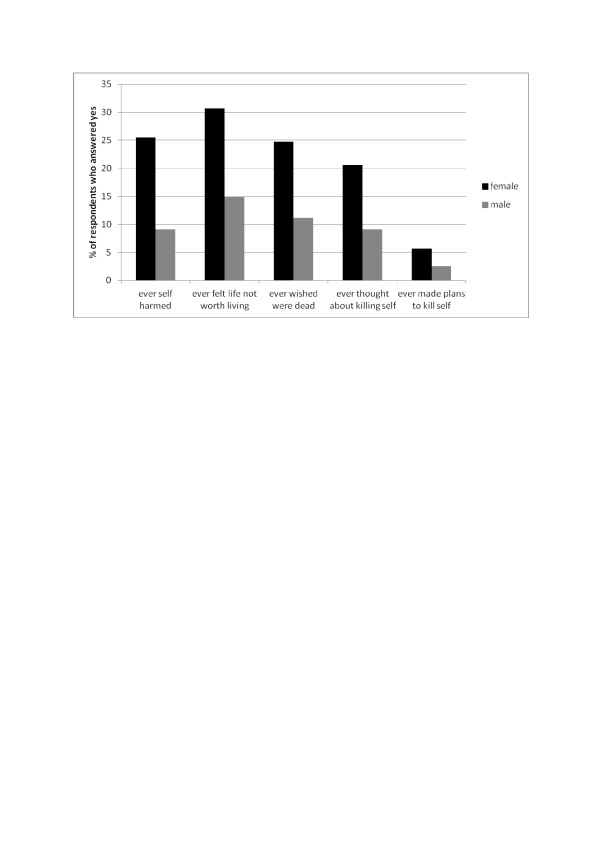
Percentage of respondents who have ever self harmed or experienced suicidal thoughts, by gender.